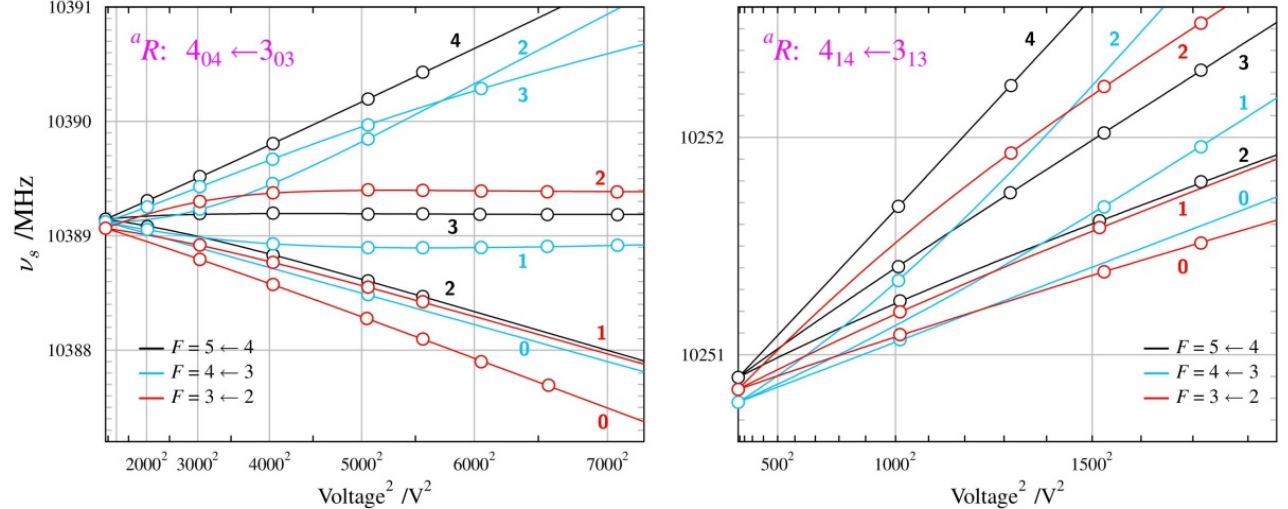
Figure 8. Summary of Stark measurements for the most stable, AA conformer, of n -butyl cyanide. In this case, actual frequencies, rather than Stark shifts, are plotted as a function of the square of the applied voltage. The molecule has nuclear quadrupole hyperfine structure so that each rotational transition is split into several components characterised by values of the F quantum number, and each such component becomes further split into Stark components for distinct values of M F (marked next to each Stark curve). Significant departures from the straight-line second-order behaviour are visible (see text) and allow determination of both non-zero dipole moment components from measurements only on transitions allowed by the µ a dipole moment component.